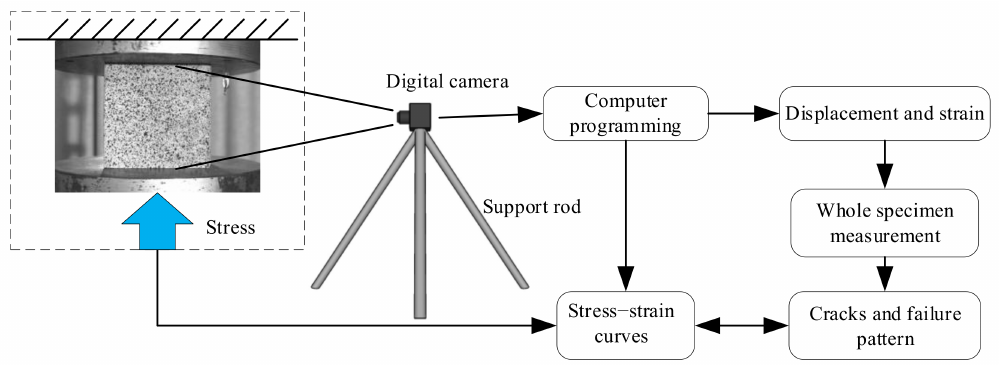
Figure 2. Digital image correlation (DIC) programming.